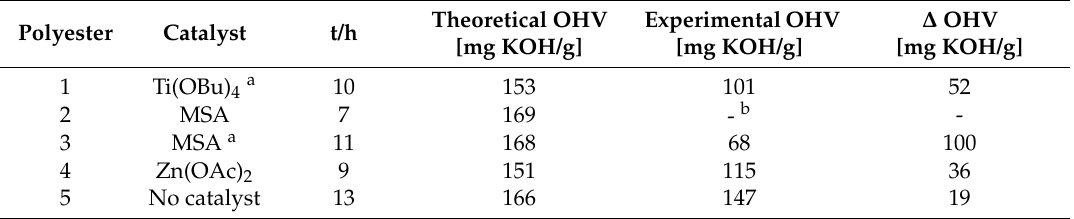
Table 2. Theoretical and experimental OHV of the different polycondensation experiments.